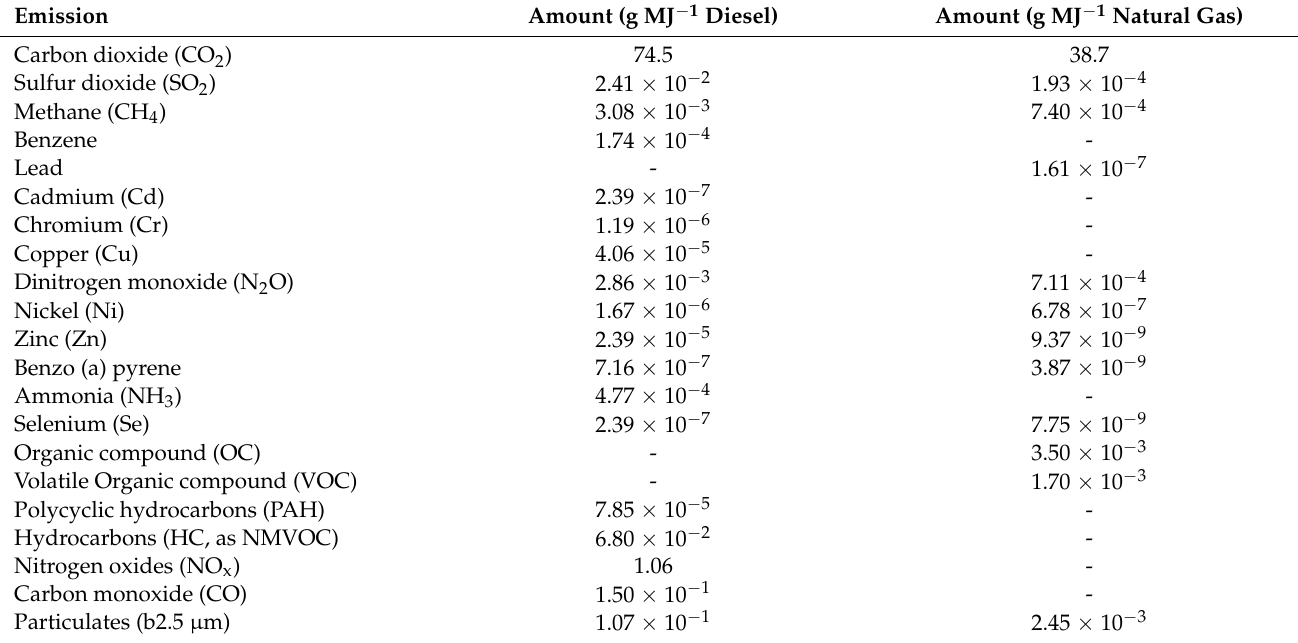
Table 3. Equivalent emission of 1 MJ diesel fuel from burning per liter of diesel/m 3 natural gas